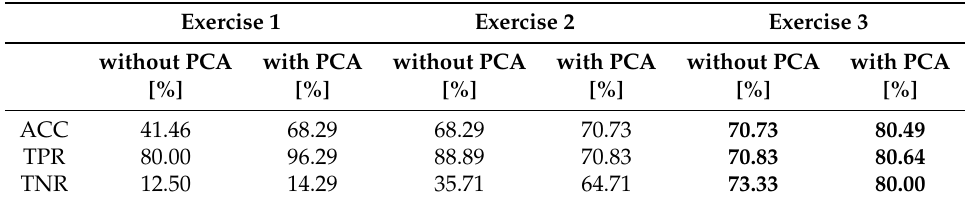
Table 5. Evaluation of the k-means classifier; accuracy (ACC), sensitivity (TPR), and specificity (TNR).